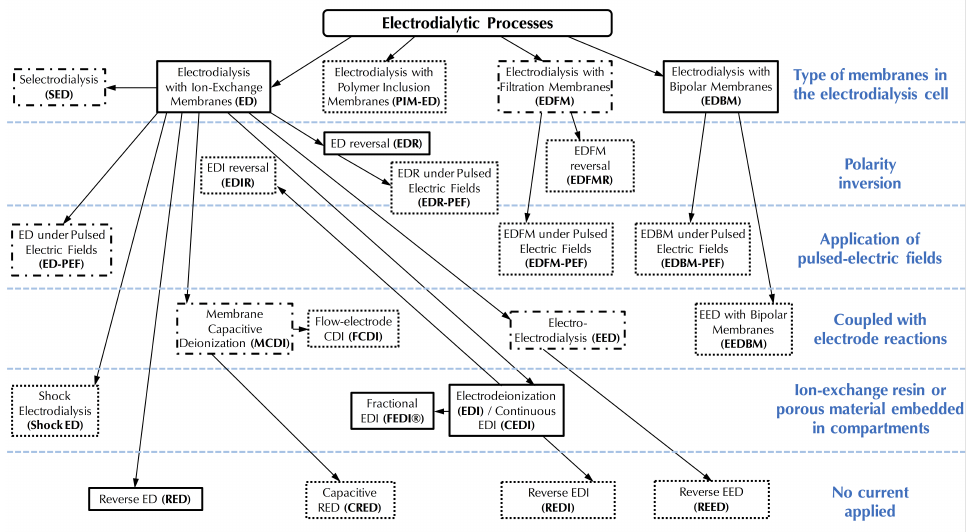
Figure 1. Electrodialytic processes and their characteristics. In solid lines ( _____ ), technologies available at an industrial scale, in dotted lines ( - - - - - ), technologies at laboratory scale, combination of solid and dotted lines , technologies for which scale-up is